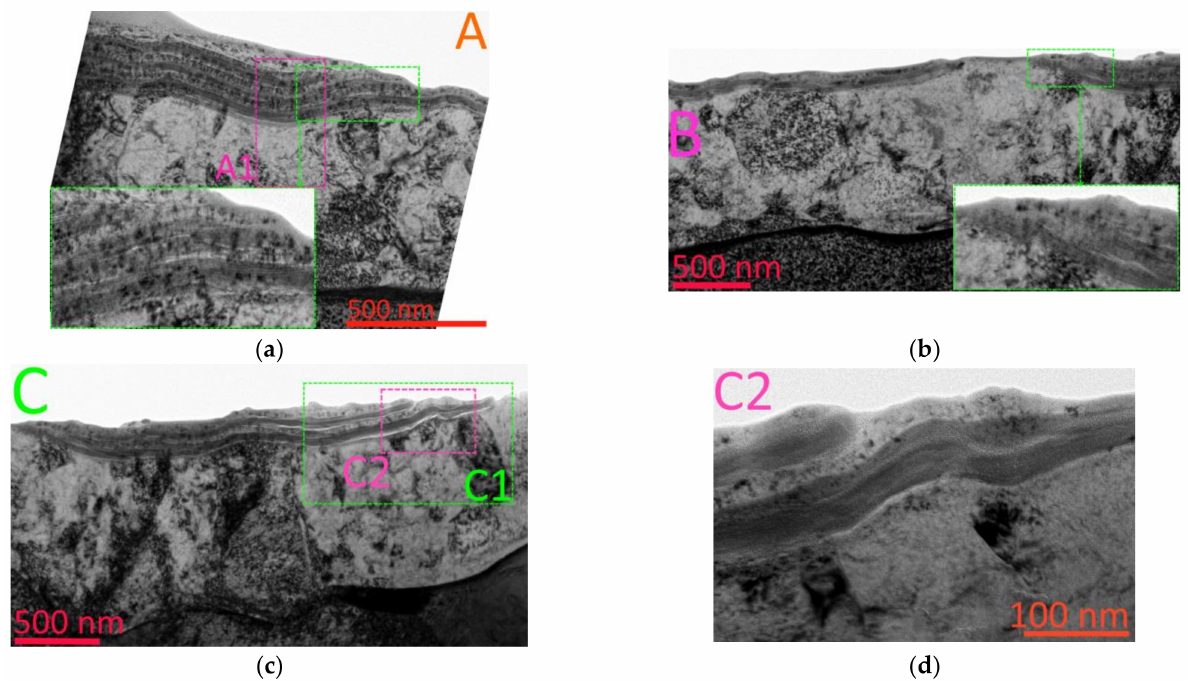
Figure 6. Investigation of the failure of the nanolayer structure of the coating. ( a , b ) (Y,Ti,Al)N nanolayers retain their layered structure, ( c , d ) (Y,Ti,Al)N nanolayers have lost their layered structure (possible YN → Y 2 O 3 transformation)